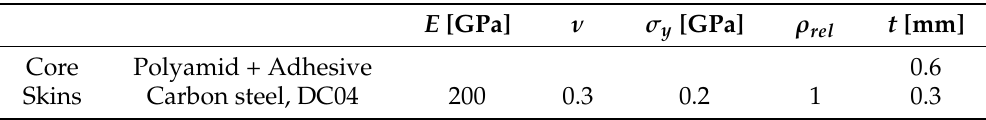
Table 1. Material data for the CC030030PC-120 TMK-T7609 configuration of Hybrix TM used in the study. E refers to Young’s modulus, ν to Poisson’s ratio, σ y to the initial yield stress, ρ rel to the relative density, and t corresponds to the thickness.